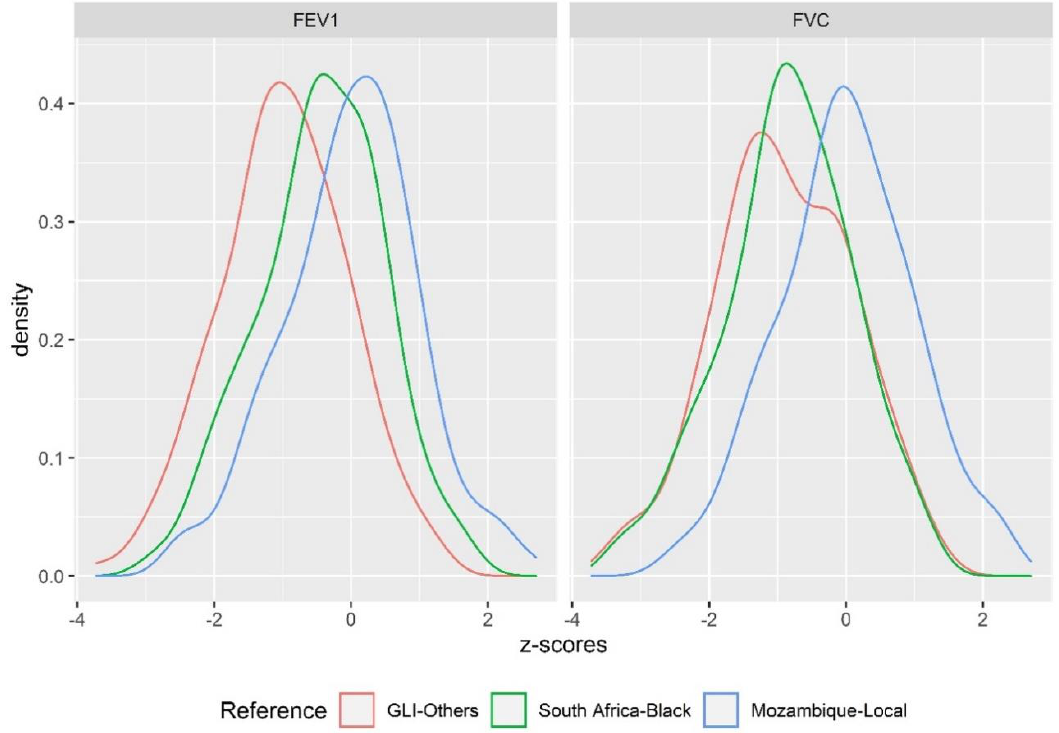
Figure 2. The density distribution of z-scores from the Mozambican sample based on three different reference standards (prediction equations).